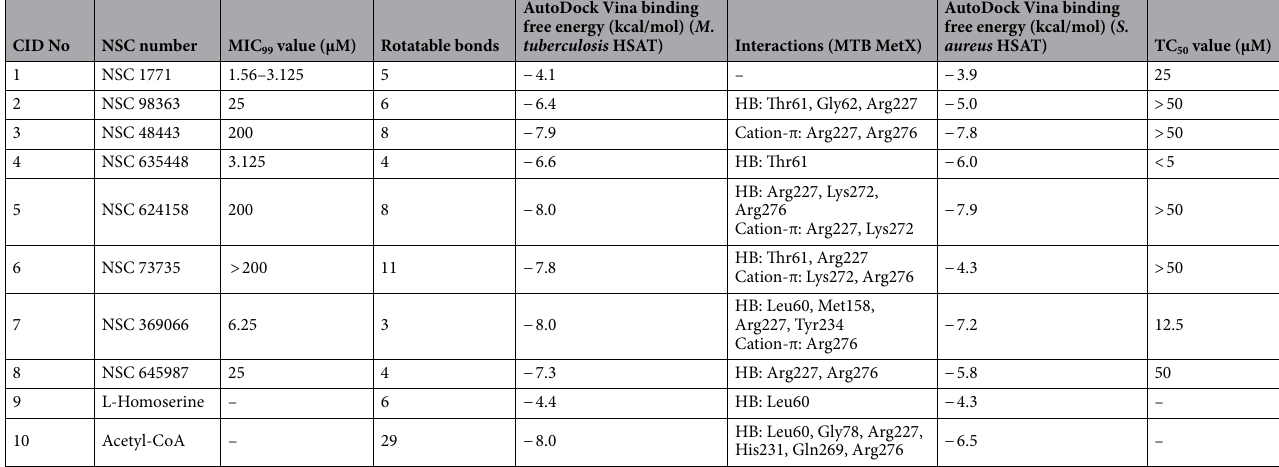
Table 1. The details of interacting residues in docked poses of primary hits in Rv3341 modelled protein using AutoDock Vina. HB stands for Hydrogen bond.